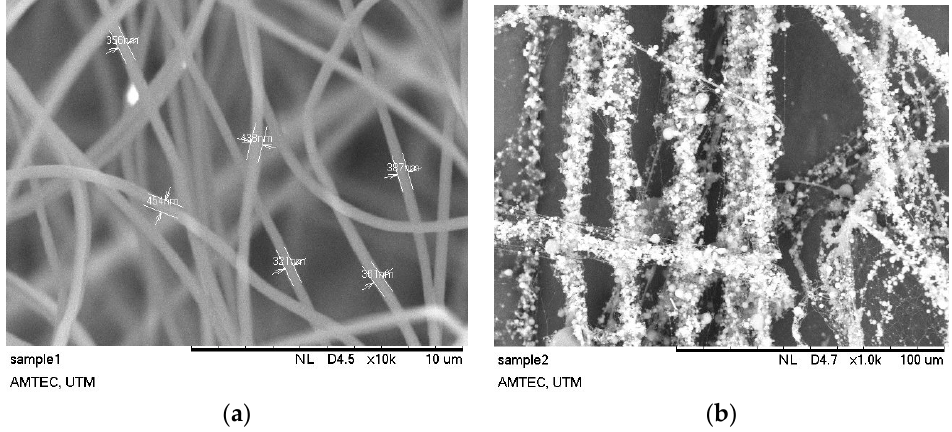
Figure 7. Fiber diameter for: ( a ) SP/e-spunCL15; and ( b ) SP/e-spunCL10. Table 3. Fibers diameters of electrospun SPEEK/Cloisite